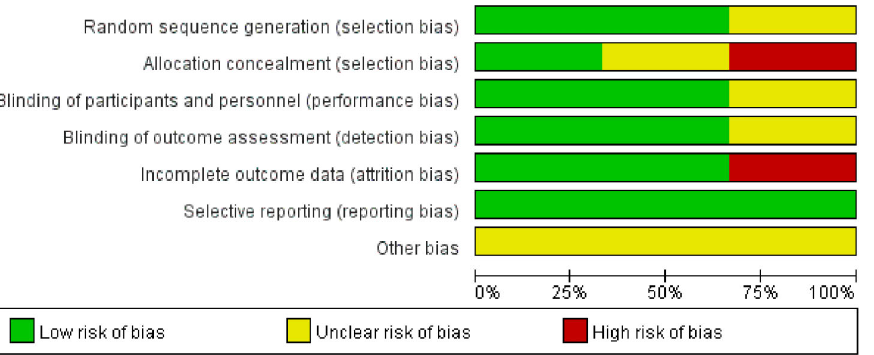
Figure 2. Risk of bias graph: review authors’ judgments about each risk of bias item presented as percentages across all included studies.